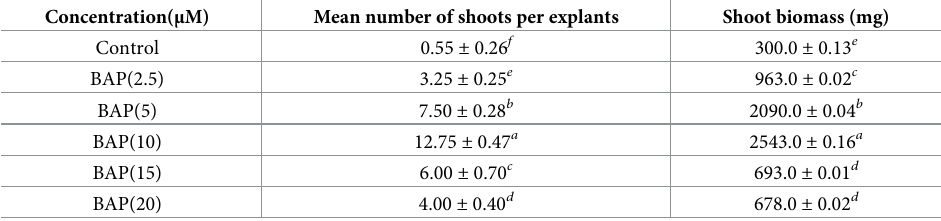
Table 3. Effect of benzyl amino purine (BAP) on multiple shoot proliferation in liquid MS medium.